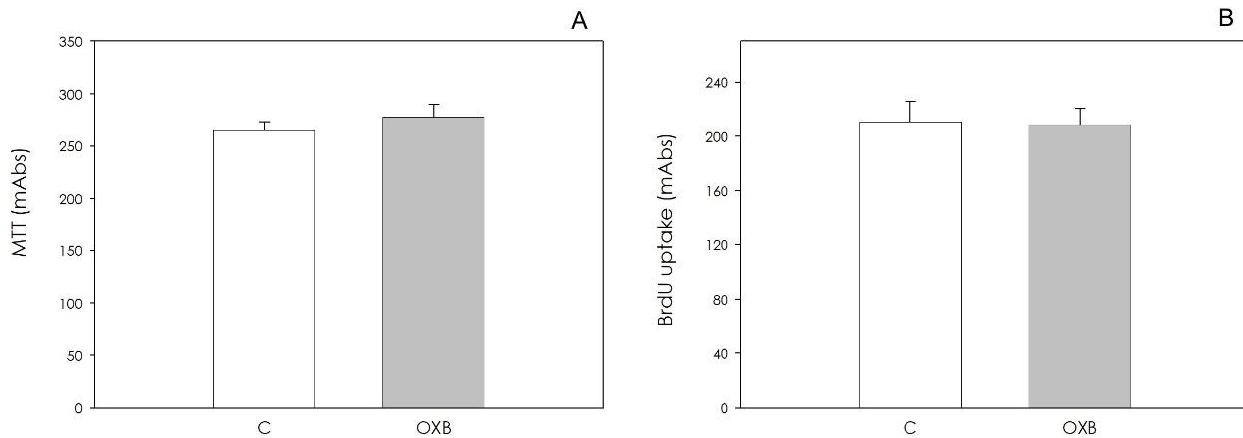
Figure 6. Effect of the 48 h treatment with orexin B (OXB; 10 nM) on swine aortic endothelial cells’ viability, evaluated by MTT test ( A ) and on granulosa cell proliferation evaluated using 5-bromo-2′-deoxyuridine (BrdU) incorporation assay test ( B ).